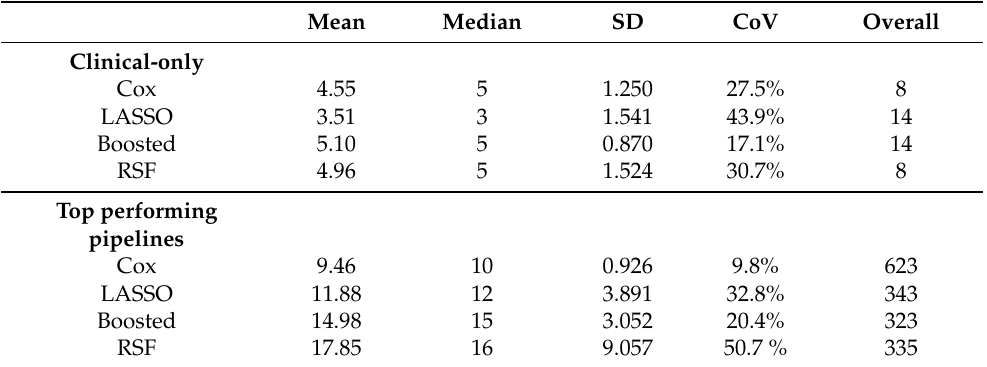
Table 3. Summaries of final predictive model sizes (i.e., number of variables used) selected within the clinical-only models and best-performing pipelines, in terms of their mean, median, standard deviation, and coefficient of variation (CoV), as well as the overall number of features selected at least once across 100